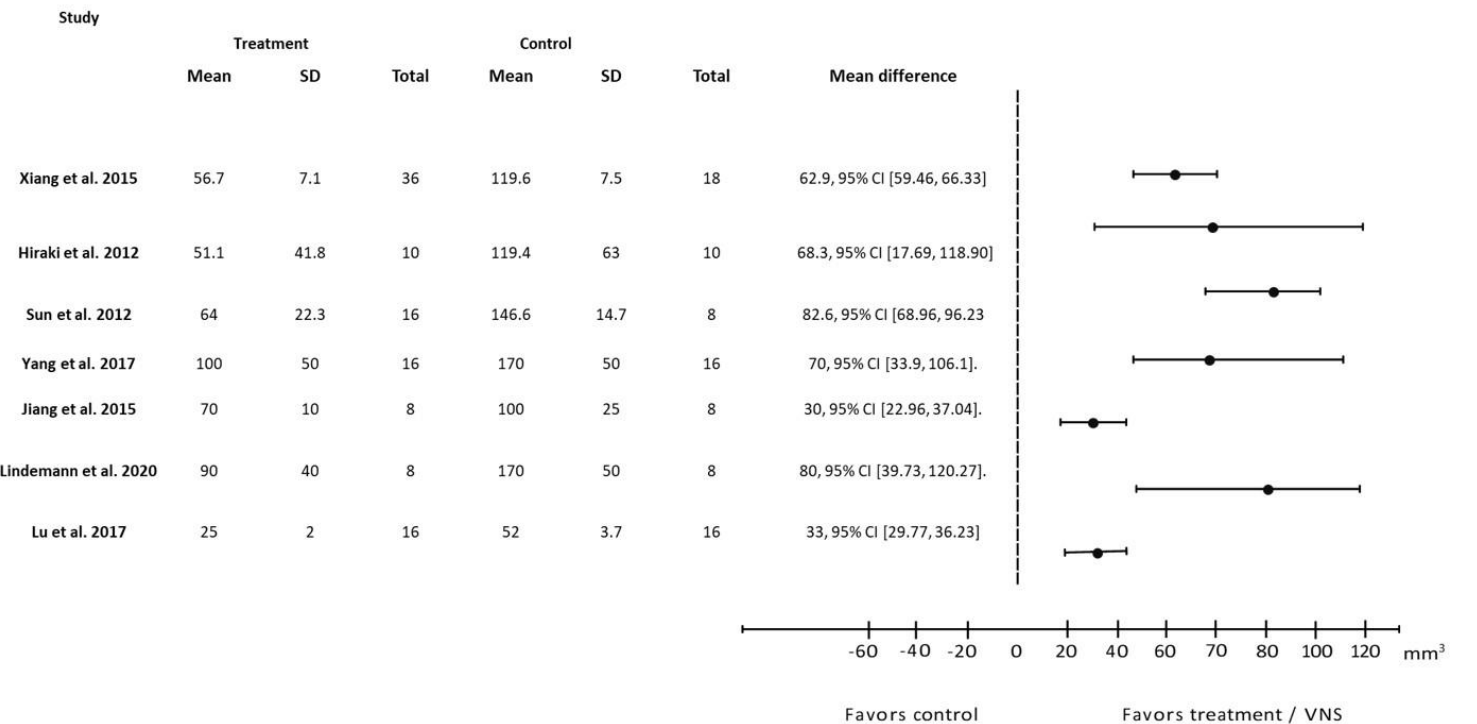
Figure 4. Forest plot: the outcome of vagus nerve stimulation (VNS) on infarct volume reported in mm 3 . The effect of each study (“favors control” , “favors treatment” , or “no effect”) was estimated through the standardized mean difference (horizontal axis). The dashed vertical line at 0 indicates that the study was determined to have “no effect” . The horizontal bars in each chart plot represent the mean difference with a 95% confidence interval for each study [21,24 – 26,31,34,40].